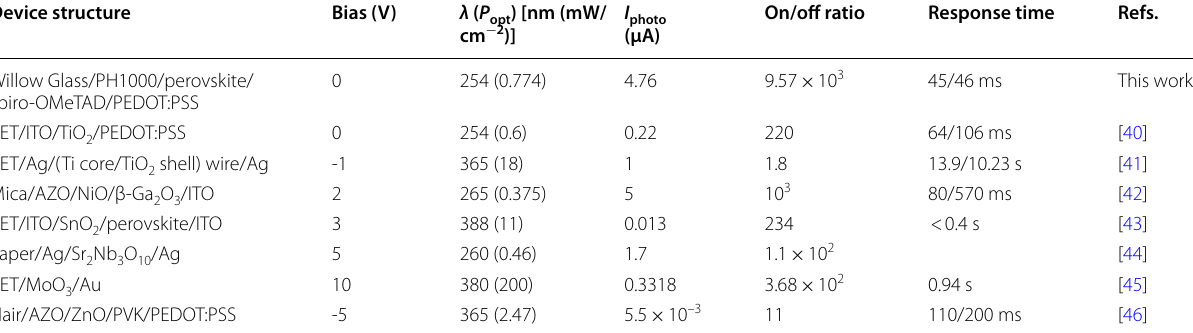
Table 1 Performance comparisons of previous flexible photodetectors Device